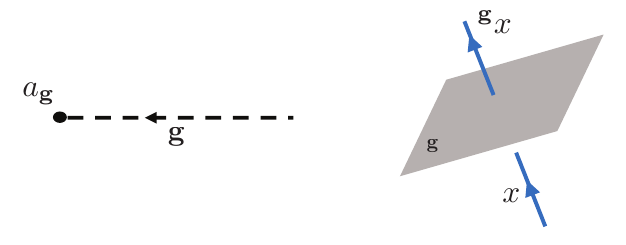
Figure 1: Left: A g defect in space. Branch cut is depicted by dashed line; there can be topologically distinct endpoints, labeled by a . Right: g defect is a two-dimensional g sheet in space-time; an anyon x is permuted to g x upon crossing the